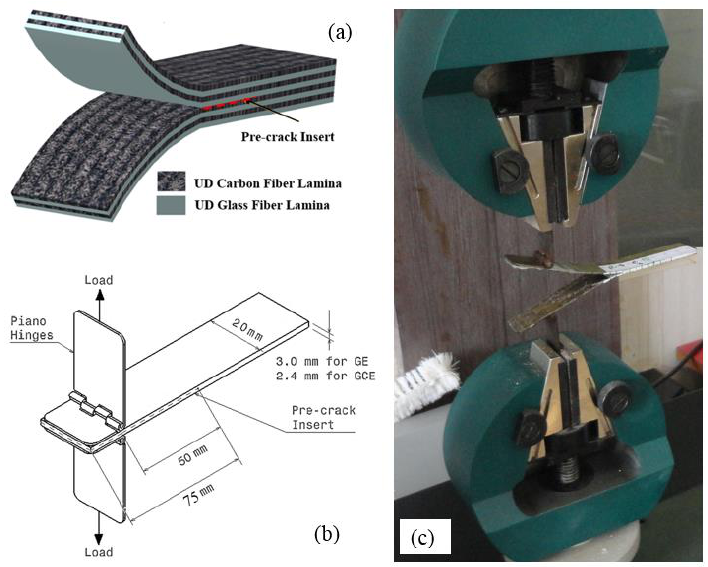
Figure 1. Schematic illustrations depicting ( a ) Lamina layup of GCE laminates. ( b ) Specification of DCB specimen. ( c ) Mode-I fracture test of GCE specimen.